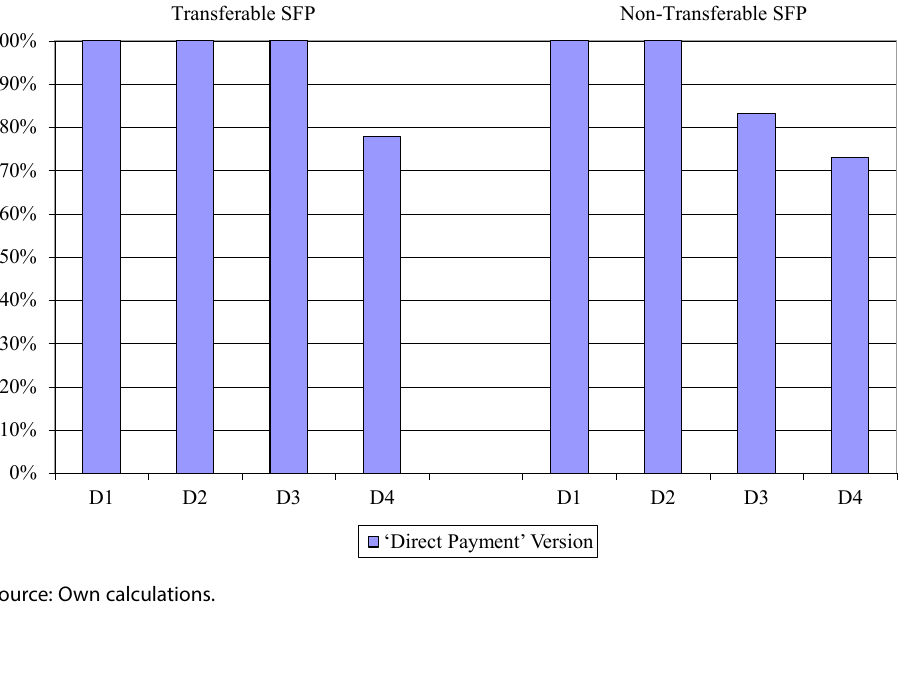
Figure 10. Lease prices for grassland (mountain region): Average value of all newly leased plots in the last 3 forecast years (100% corresponds to the lease-price level in 2006-2008).